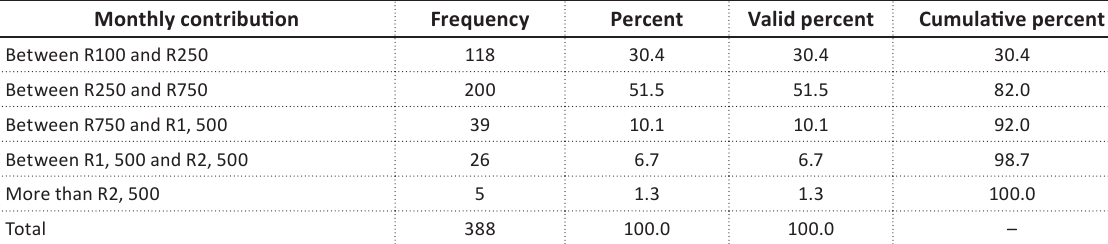
Table 2. Response on monthly contributions per stokvel